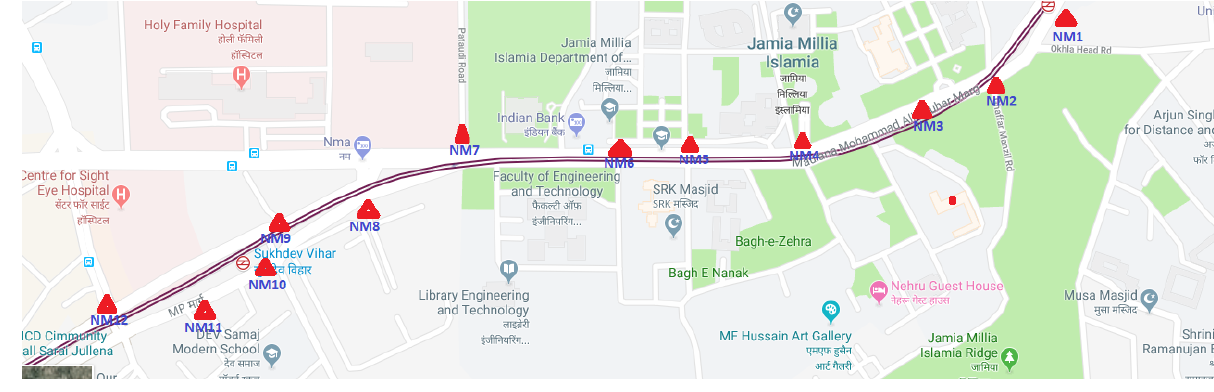
Figure 4: Temporary noise monitoring station for hourly average noise monitoring